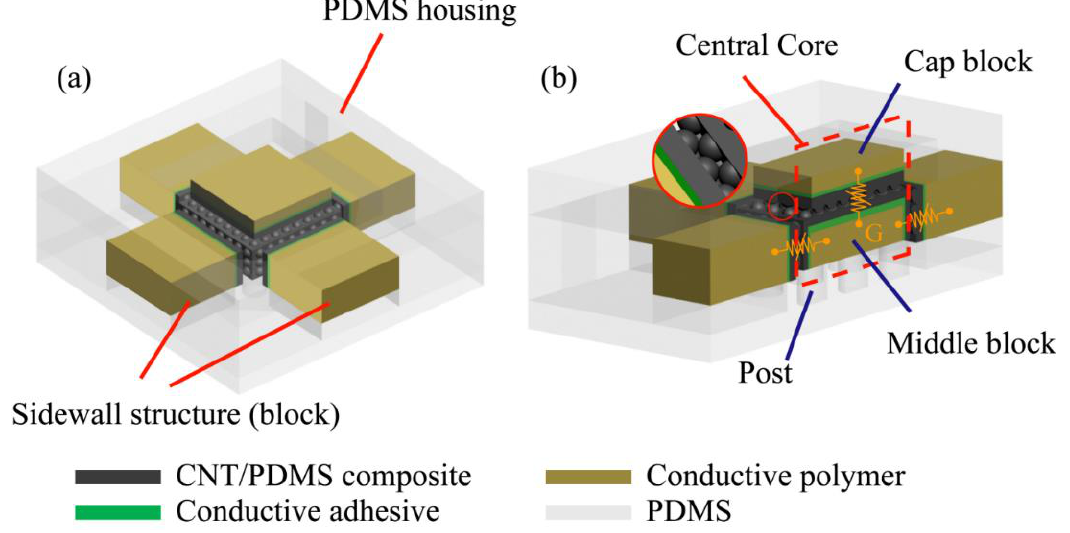
Figure 1. 3D Schematics of the proposed sensor: ( a ) five sensing elements, one for normal force and four for shear force, are embedded to measure the magnitude and direction of applied forces. The central core is surrounded by four sidewall structures; ( b ) external force changes the contact area between two CNT/PDMS composite films. The CNT/PDMS composite films are physically and electrically connected with conductive polymer by conductive adhesive. Conductive polymer blocks act as electrodes. “G” means that the middle block acts as a common electrical